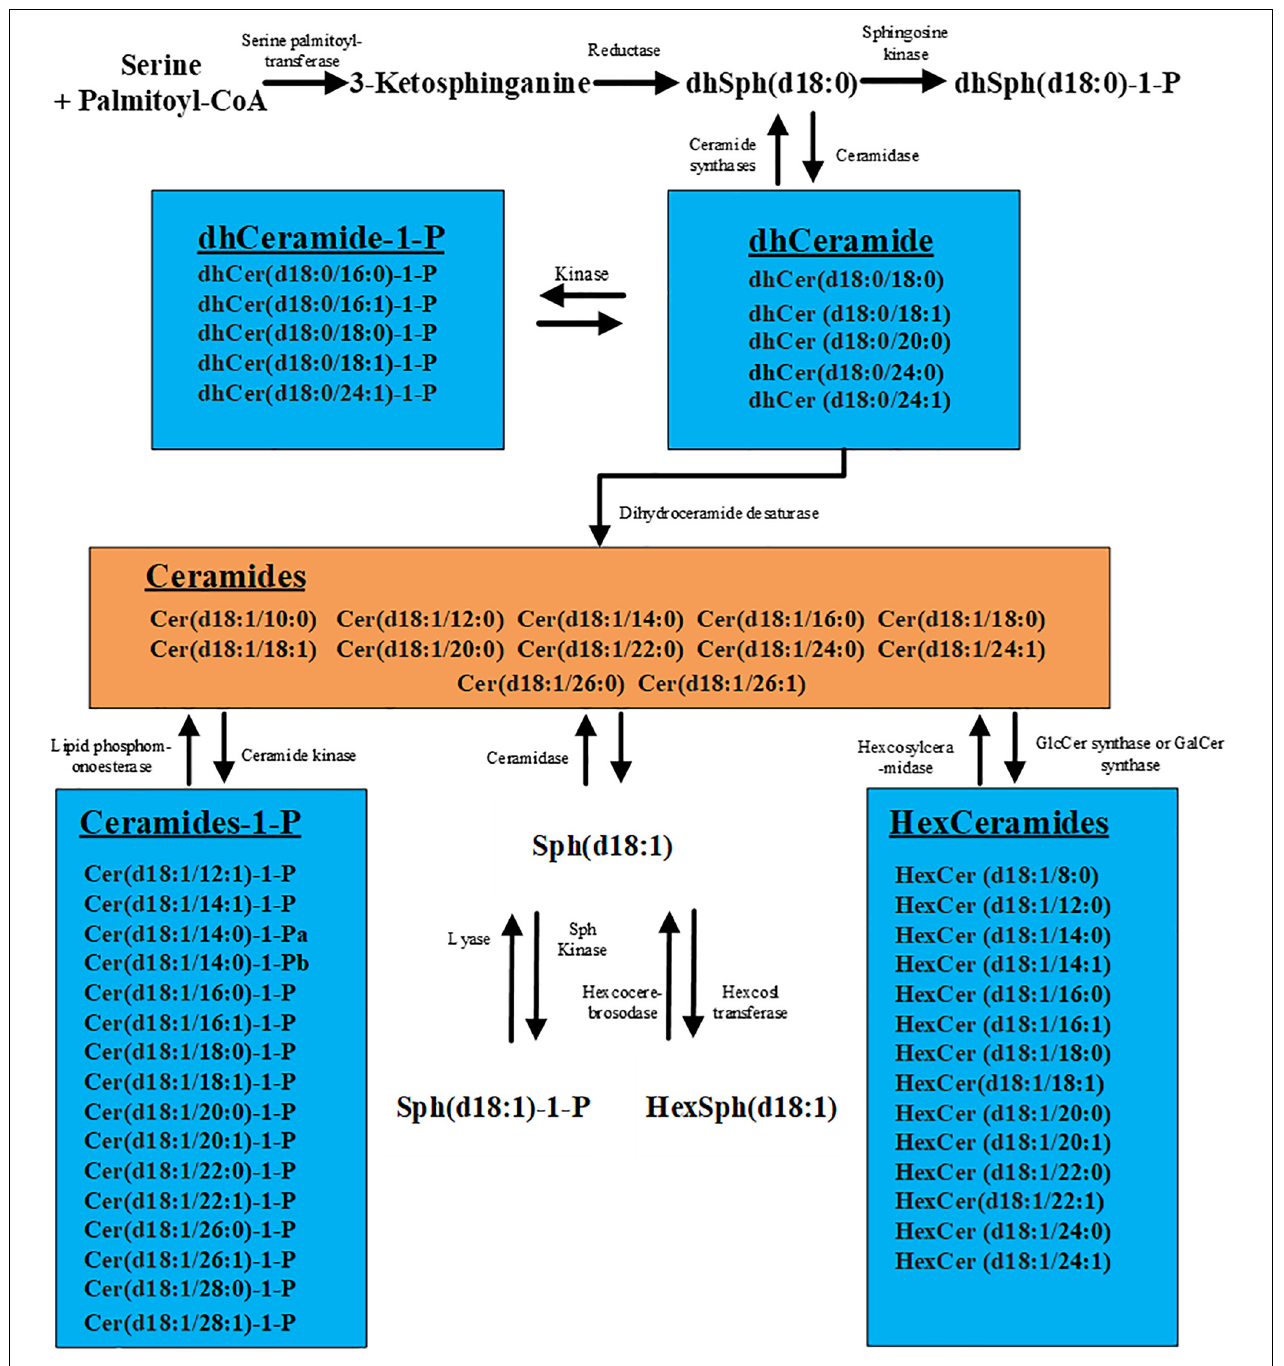
FIGURE 1 | Metabolic pathways of sphingolipids. The figure contains all the 57 sphingolipids examined in this study.